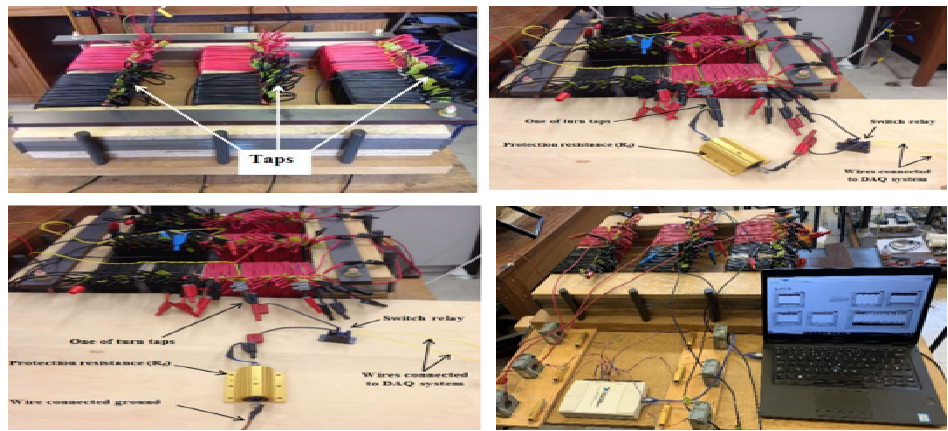
Figure 1. Schematic of the system in the